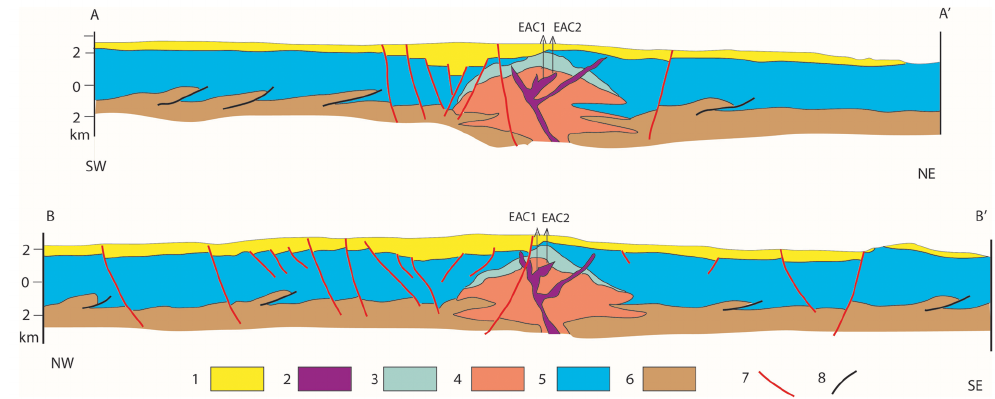
Figure 13. The two main cross-sections used for modelling the Acoculco area, see Fig. 7. Symbols: 1 – vulcanite (Pliocene-Holocene); 2 – Quaternary dyke; 3 – skarn and marble; 4 – crust involved in thermal anomalies through time: magma chambers originating the different volcanic events are supposed to be developed within this volume; 5 – Jurassic-Cretaceous limestone; 6 – crystalline rocks, mainly phyllite (Paleozoic); 7 – Neogene-Quaternary normal to oblique slip faults; 8 – thrust faults related to the Laramide orogenesis (Oligocene).